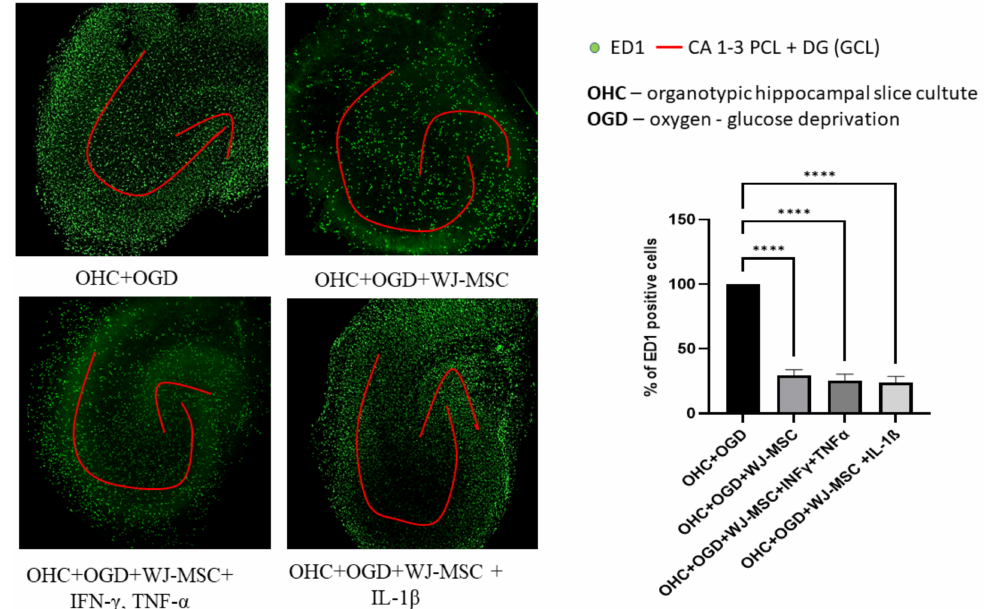
Figure 8. Immunomodulatory effect of WJ-MSC ex vivo. Increase in number of microglia in rat hippocampal organotypic slice culture (OHC) 24 h after OGD as indicated by cell labelling with ED1 marker (green). Representative images of injured rat hippocampal organotypic slice culture (OHC) used for microglia quantification. Co-culture with WJ-MSC evoke decrease of ED1+ cells. The effect is independent from WJ-MSC pretreatment with proinflammatory cytokines. Results are mean values (one-way ANOVA followed by Tukey’s test) for 3 independent experiments ± SD; **** p <